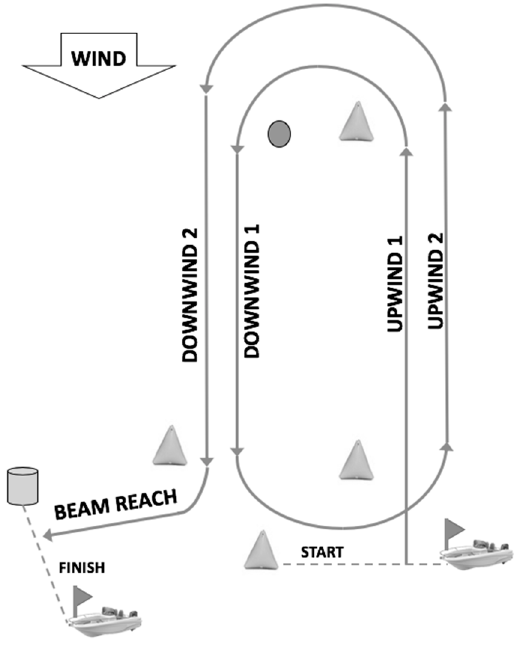
Figure 2. Regatta race course.